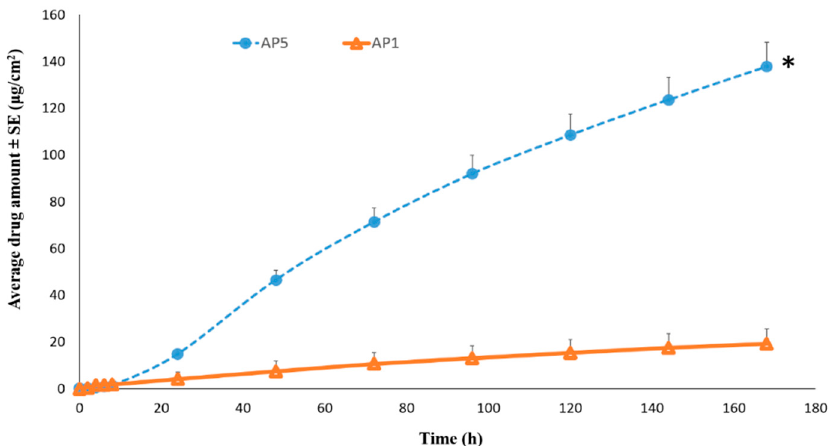
Figure 4. Permeation profiles of TAF from acrylate based patches across human epidermis. * Represents statistical significant difference, Student’s t test ( p < 0.05). AP1: Acrylate patch containing 2% TAF, AP5: Acrylate patch containing 10% TAF.